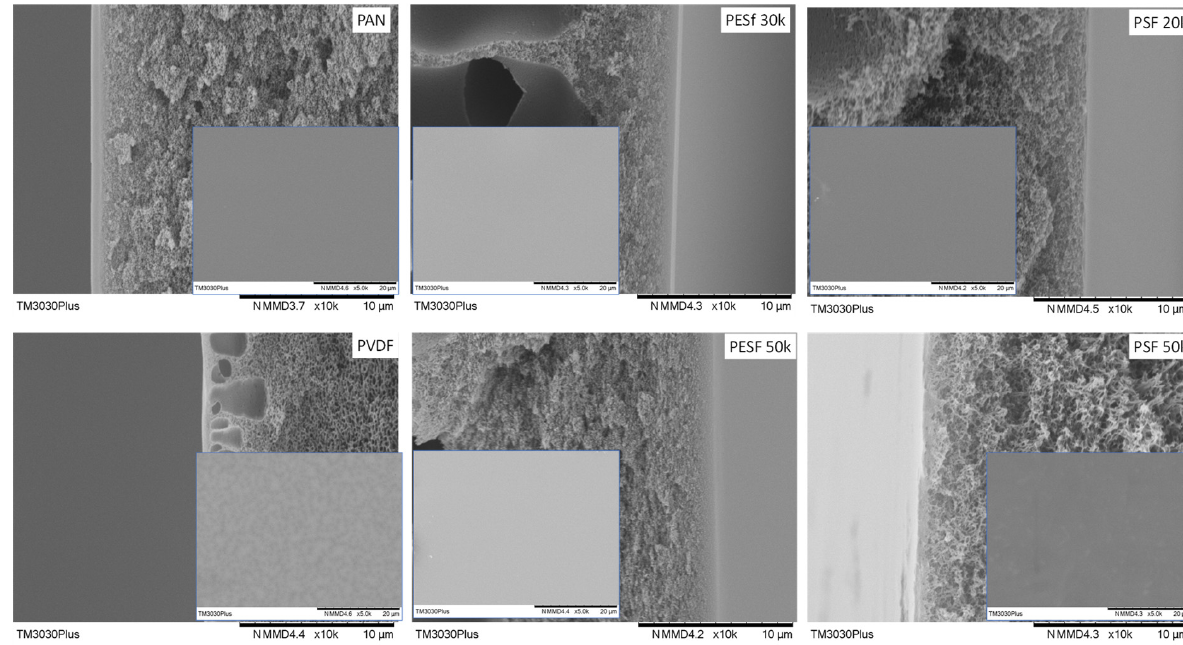
Figure 12. Membrane morphology of PVA TFC membranes coated on selected supports.